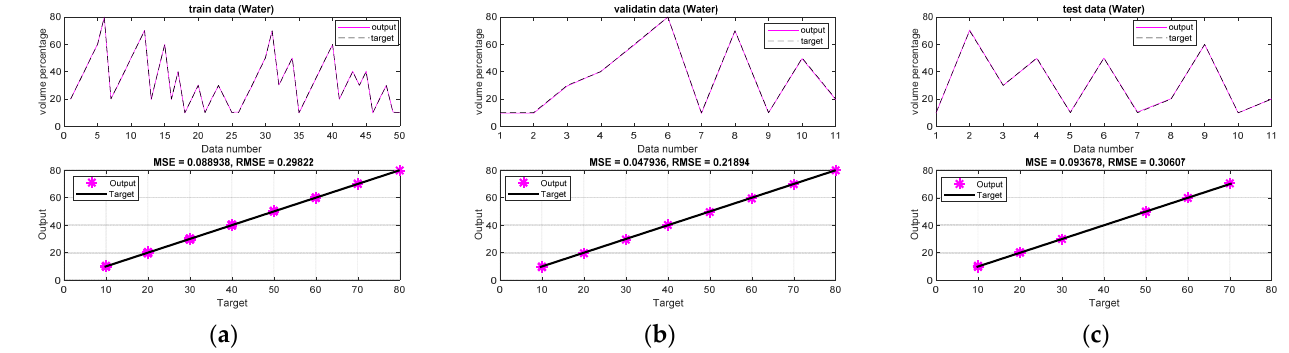
Figure 9. Regression diagram related to the prediction of water volume percentage for ( a ) training, ( b ) validation, and ( c ) test data.